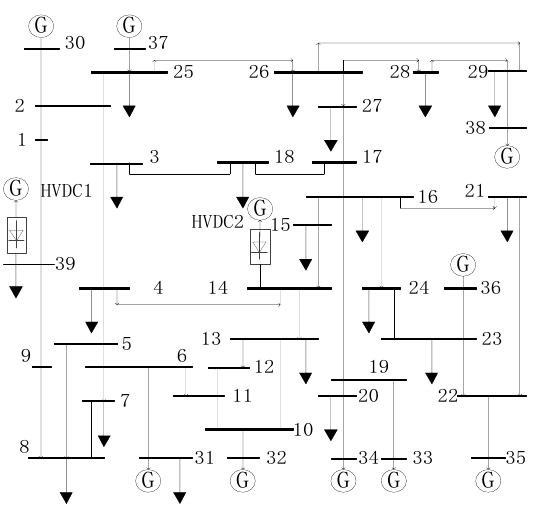
Figure 3. The diagram of reformed IEEE 39-bus system.